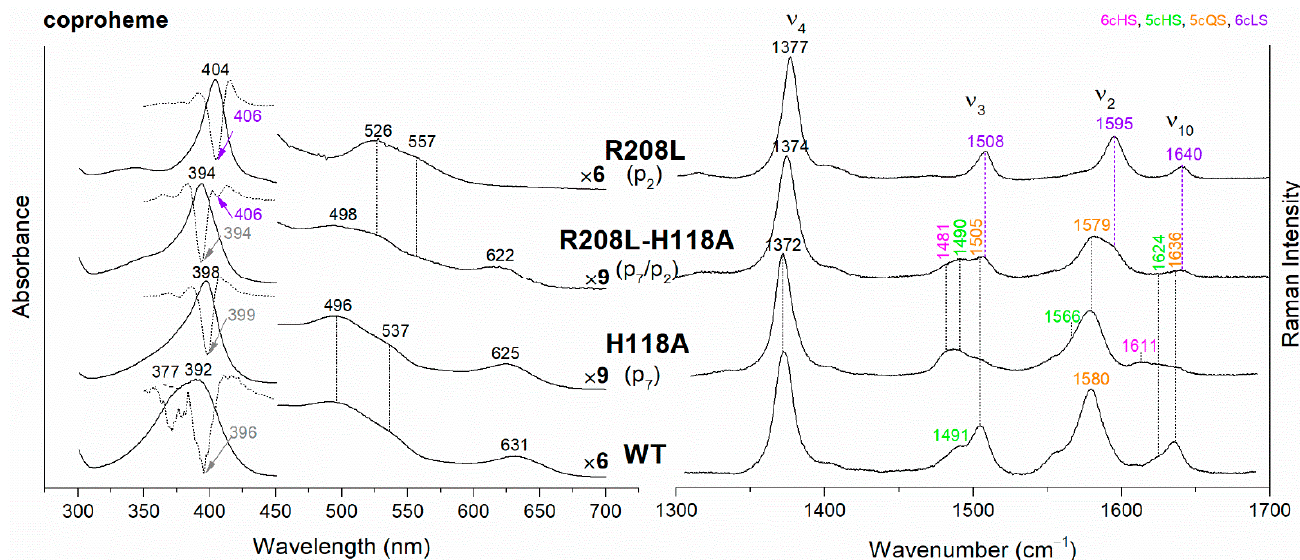
Figure 3. ( Left ) UV-vis electronic absorption spectra (solid lines) and their second derivative (dashed lines), and ( Right ) RR spectra in the high wavenumber region of coproheme complexes of Cd ChdC WT and variant complexes. In brackets, the propionate, whose corresponding H-bond is removed by mutation, is reported. The band wavelengths assigned to the 6cLS species are indicated in violet. The RR core-size marker band wavenumbers are reported in pink, green, orange and violet for the 6cHS, 5cHS, 5cQS and 6cLS species, respectively. In black, at the side of the UV-vis spectra, are indicated the expansion factors applied in the 450–700 nm spectral range for better data visual- ization.